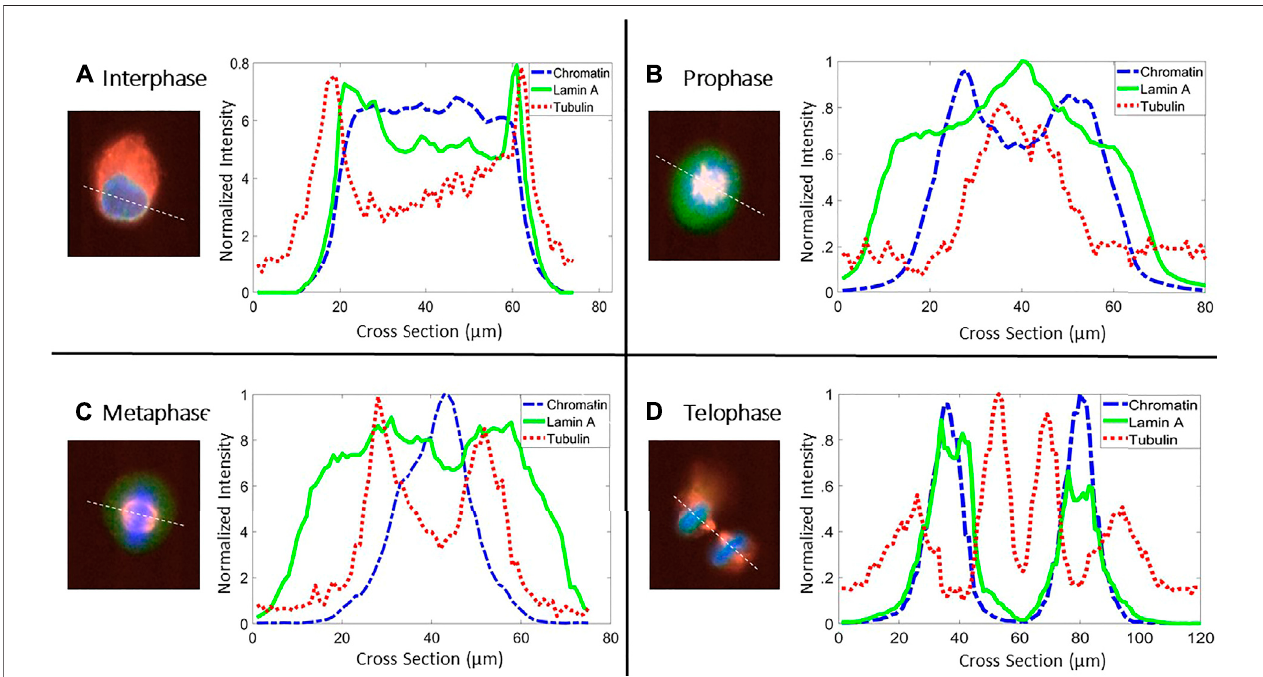
FIGURE 2 | Cross section of fl uorescent intensities. Representative cross-section of the intensities of lamin A (green solid line), chromatin (blue dashed line), and tubulin (red dotted line) in four different stages throughout the cell cycle in MEF cells. White dotted lines in the merged images denote the cross-section used for plotting the intensities. Line colors in the graphs are similar to the fl uorescent channels in the merged image (lamin A (green), tubulin (red), and chromatin (blue)).